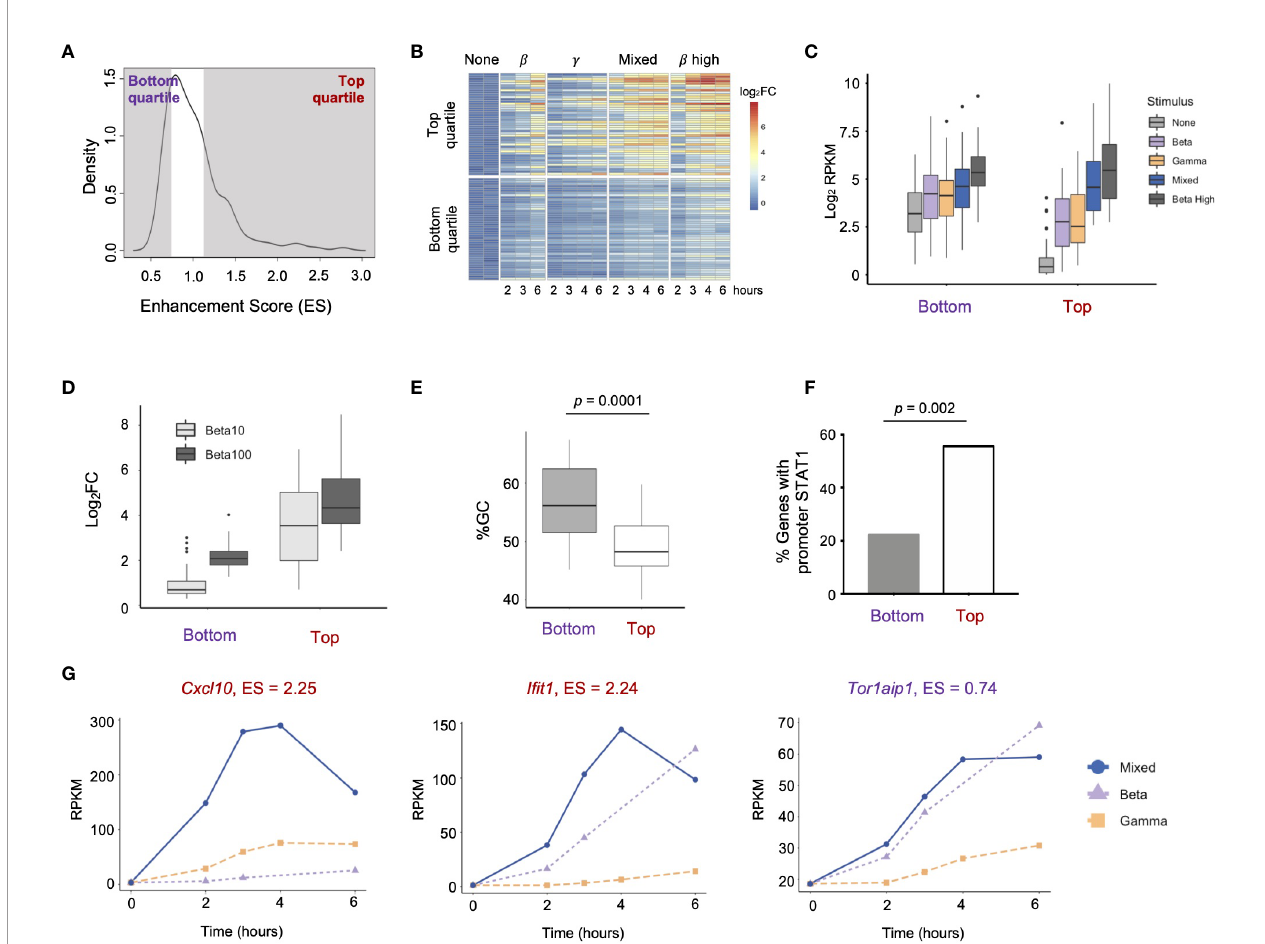
Table S1 . TF motif analysis and gene ontology analysis did not reveal any difference between the two categories. Both Top and Bottom genes contained ISRE motifs in their promoters and were enriched for IFN-related ontology terms such as “ Viral defense ” and “ Immune response ” (data not shown).